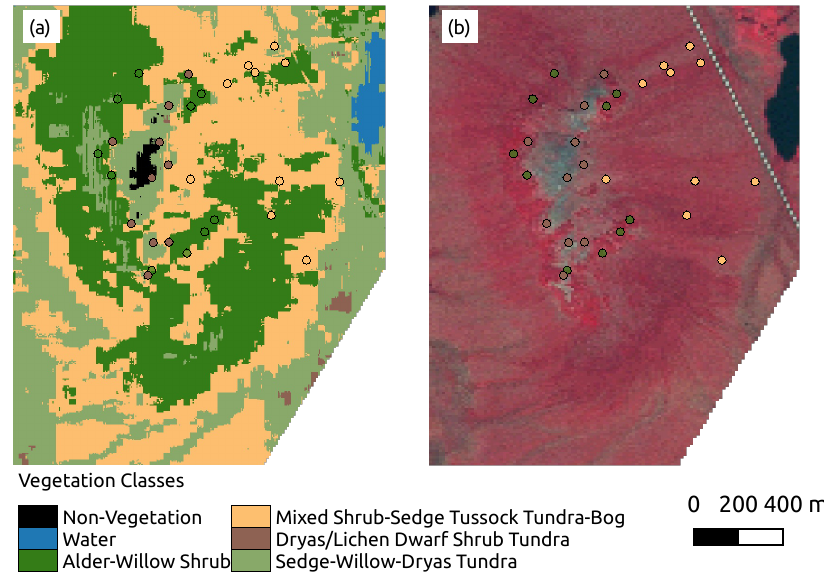
Figure 12. ( a ) Vegetation map over the field plots using the 6 × 6 patch CNN-UCVM model and ( b ) SPOT 5 false color